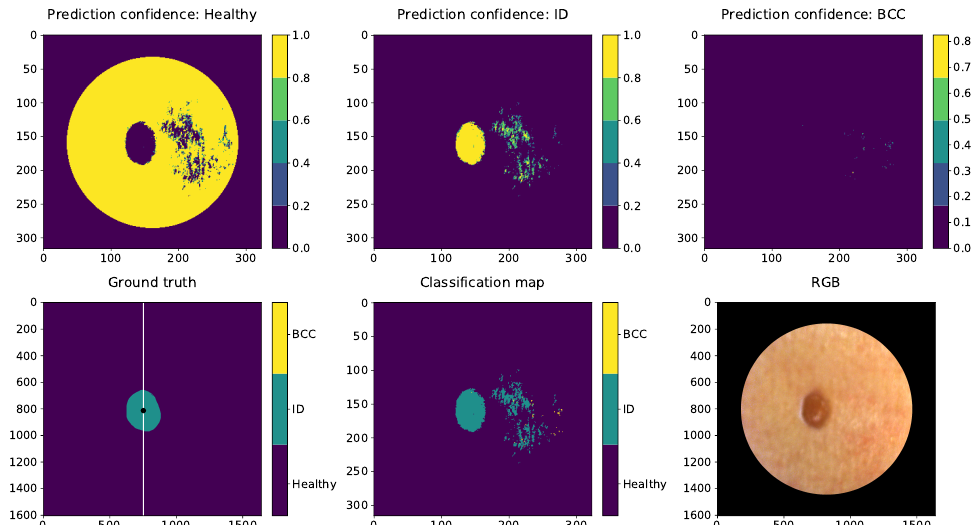
Figure 19. IN visual classification example shows that benign ID lesion pixels can be classified and the lesions can delineate efficiently. The classification map and ID prediction conference visualization show that some of the reflections or different shades of redness on the healthy skin might have confused the classification result. The lesion was captured from the right side of the patient’s back. The unit of measures is smaller with prediction maps since the HS images were windowed with 5 pixels